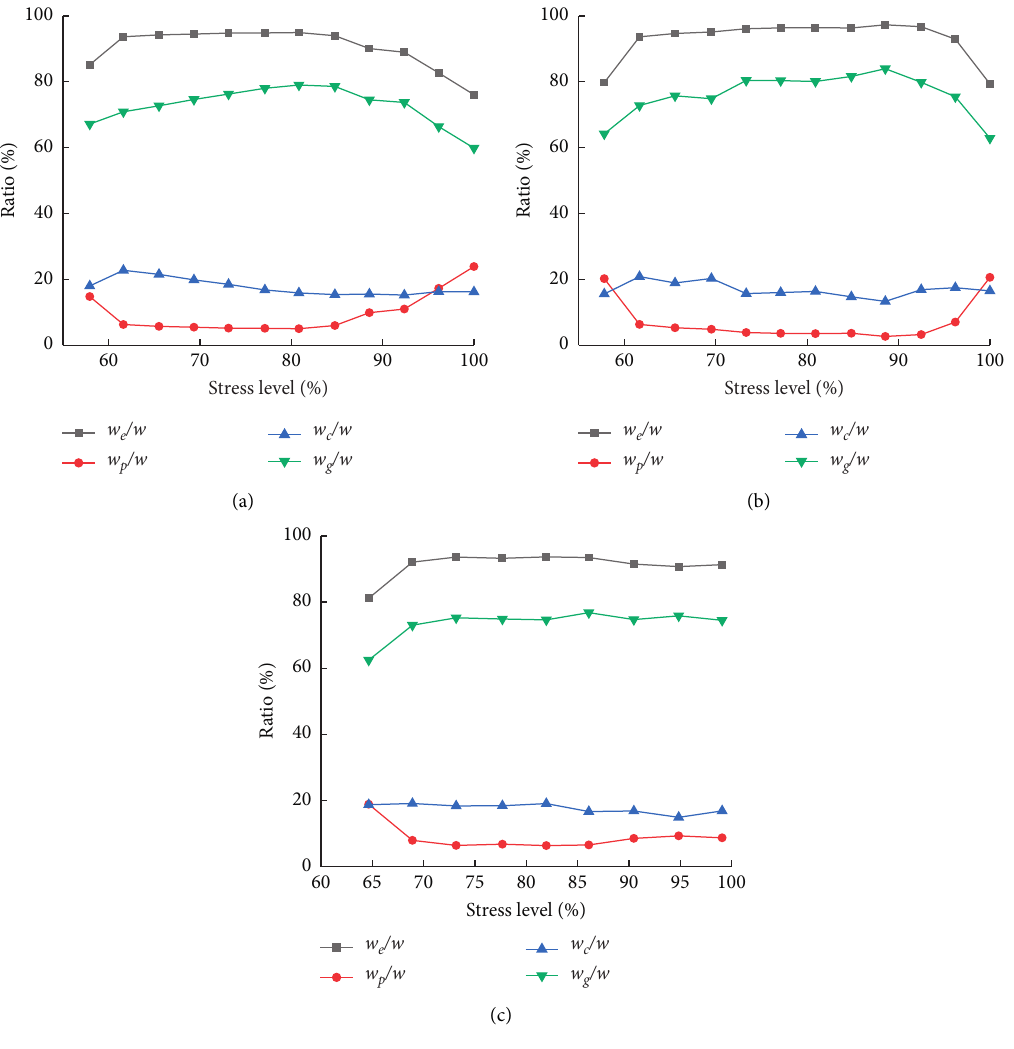
Figure 8: Relationship between the strain energy ratio and stress level. (a) #1. (b) #2. (c) #5.